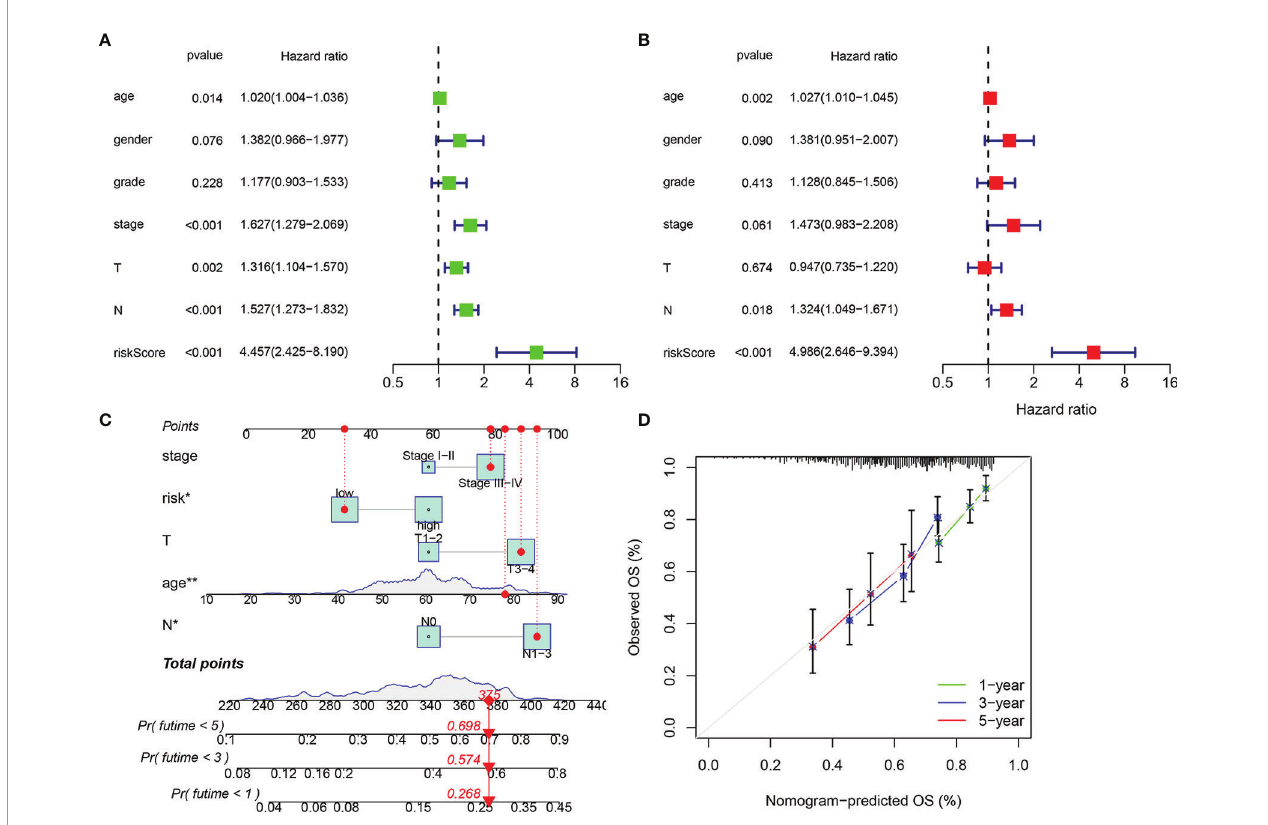
FIGURE 5 | Independence of risk score and construction of nomogram consisting of risk score and clinicopathological characteristics. Univariate Cox regression analysis was used to validate whether age, gender, grade, stage, T, N, and risk score had an independent in fl uence on prognosis (A) . Multivariate Cox regression analysis was used to validate whether age, gender, grade, stage, T, N, and risk score had independent in fl uence on prognosis (B) . Construction of integrated nomogram to predict survival in head and neck squamous cell carcinoma (HNSCC) (C) . Calibration curve for predicting 1, 3, and 5 years of overall survival (D) . * p < 0.05, ** p <